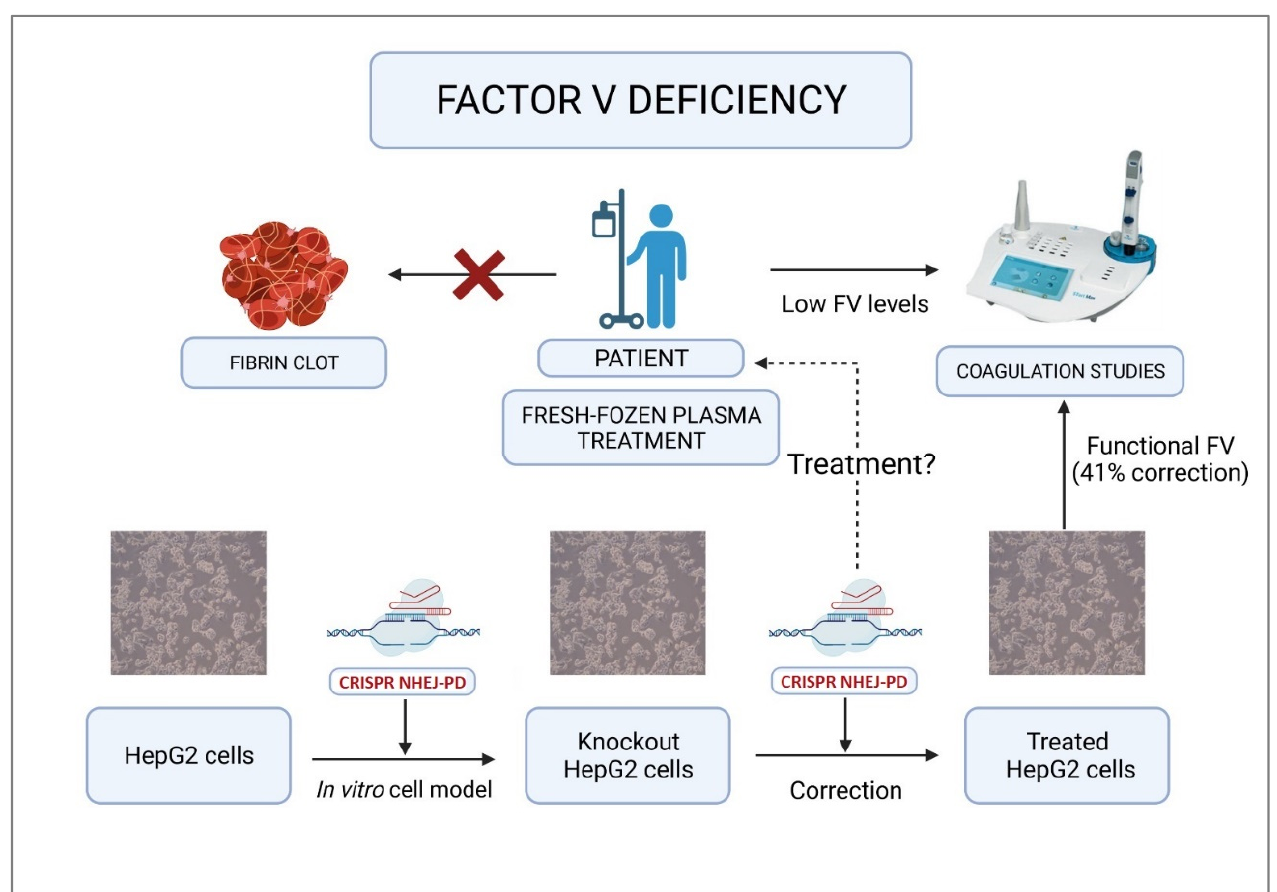
Figure 7. Summary of strategies and perspectives of the treatment of factor V deficiency. Using CRISPR/Cas9-based gene editing, the FV-producing HepG2 cell line was modified, giving rise to an in vitro knockout cell model unable to produce functional FV. The same tool was used to treat the modified cells and thereby correct the resulting mutation. This led to the recovery of 41% of FV’s functionality. This technology could constitute a gene therapy that could potentially cure FV